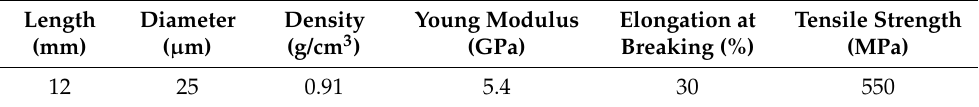
Table 5. Polypropylene fiber properties.